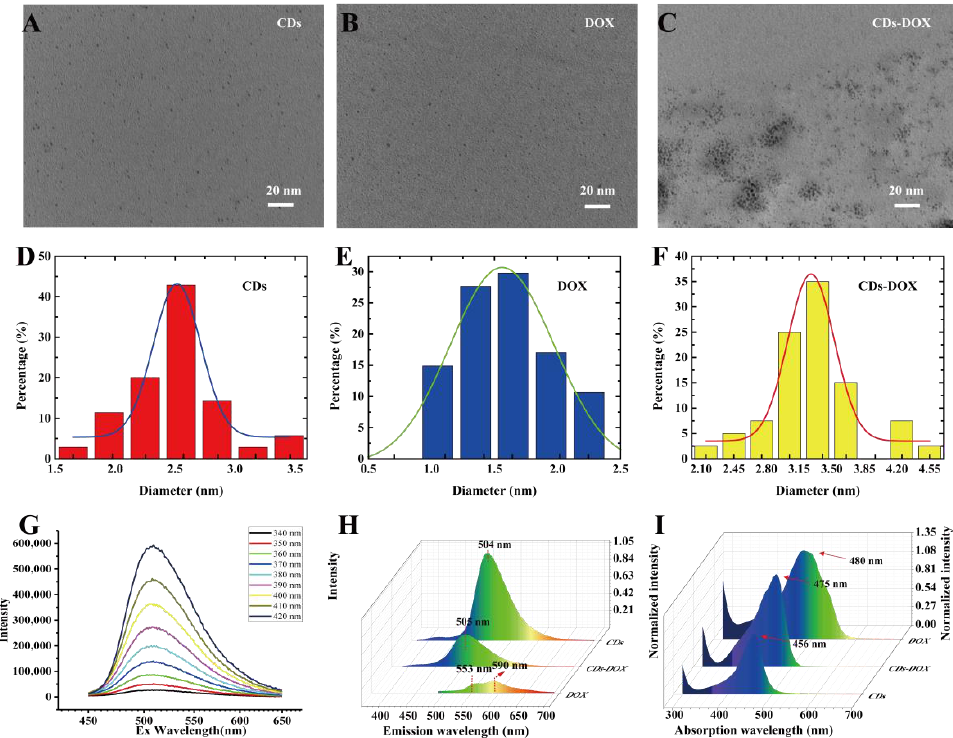
Figure 2. Morphology and characterization of CDs, DOX and CDs-DOX. ( A – C ) The TEM images of CDs, DOX and CDs-DOX. ( D – F ) The height distribution of CDs, DOX and CDs-DOX. The average heights of CDs, DOX, and CDs-DOX were approximately 2.5 nm, 1.5 nm and 3.5 nm, respectively. Additionally, one hundred particles were analyzed to prepare the size of each distribution histogram. ( G ) Emission wavelength (460 – 640 nm) spectra of CDs under different excitation wavelengths (340 – 420 nm). ( H ) The emission wavelengths of CDs and CDs-DOX were located at 504 nm and 505 nm, while DOX had two emission peaks: 553 nm and 590 nm. ( I ) The absorption peaks of CDs, DOX and CDs-DOX were located at 454 nm, 480 nm and 475 nm, respectively.